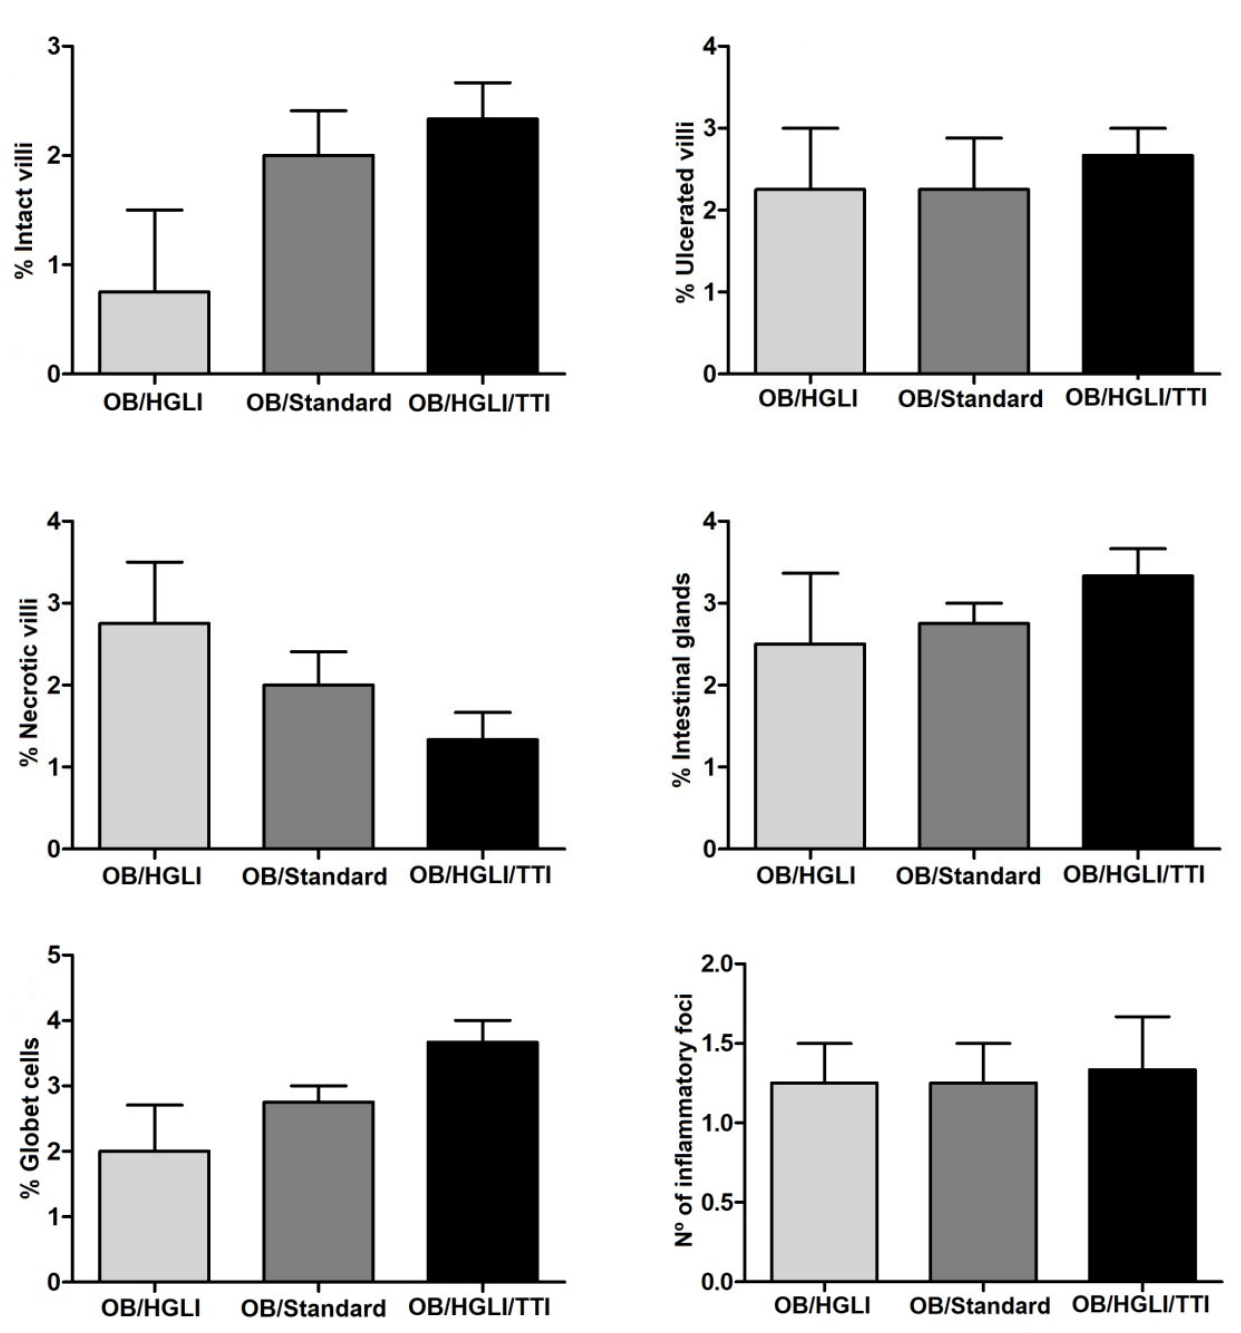
Figure 11. Semiquantitative histopathological analysis of intestinal parameters evaluated in Wistar rats with obesity induced by HGLI diet, after ten days of experiment. OB/HGLI: group without treatment, OB/Standard: group treated with a nutritionally adequate diet (standard diet Labina ® ) and OB/HGLI/TTI: group treated with the trypsin inhibitor isolated from tamarind seeds (TTI). The scores related to the percentage of intact villi, villous necrosis, presence of intestinal glands, and the amount of inflammatory foci that had a nonparametric distribution, so the Kruskal–Wallis test with Dunn’s post-hoc test was used to verify differences between pairs. The other parameters presented OB: obesity; HGLI: high glycemic index and high glycemic load